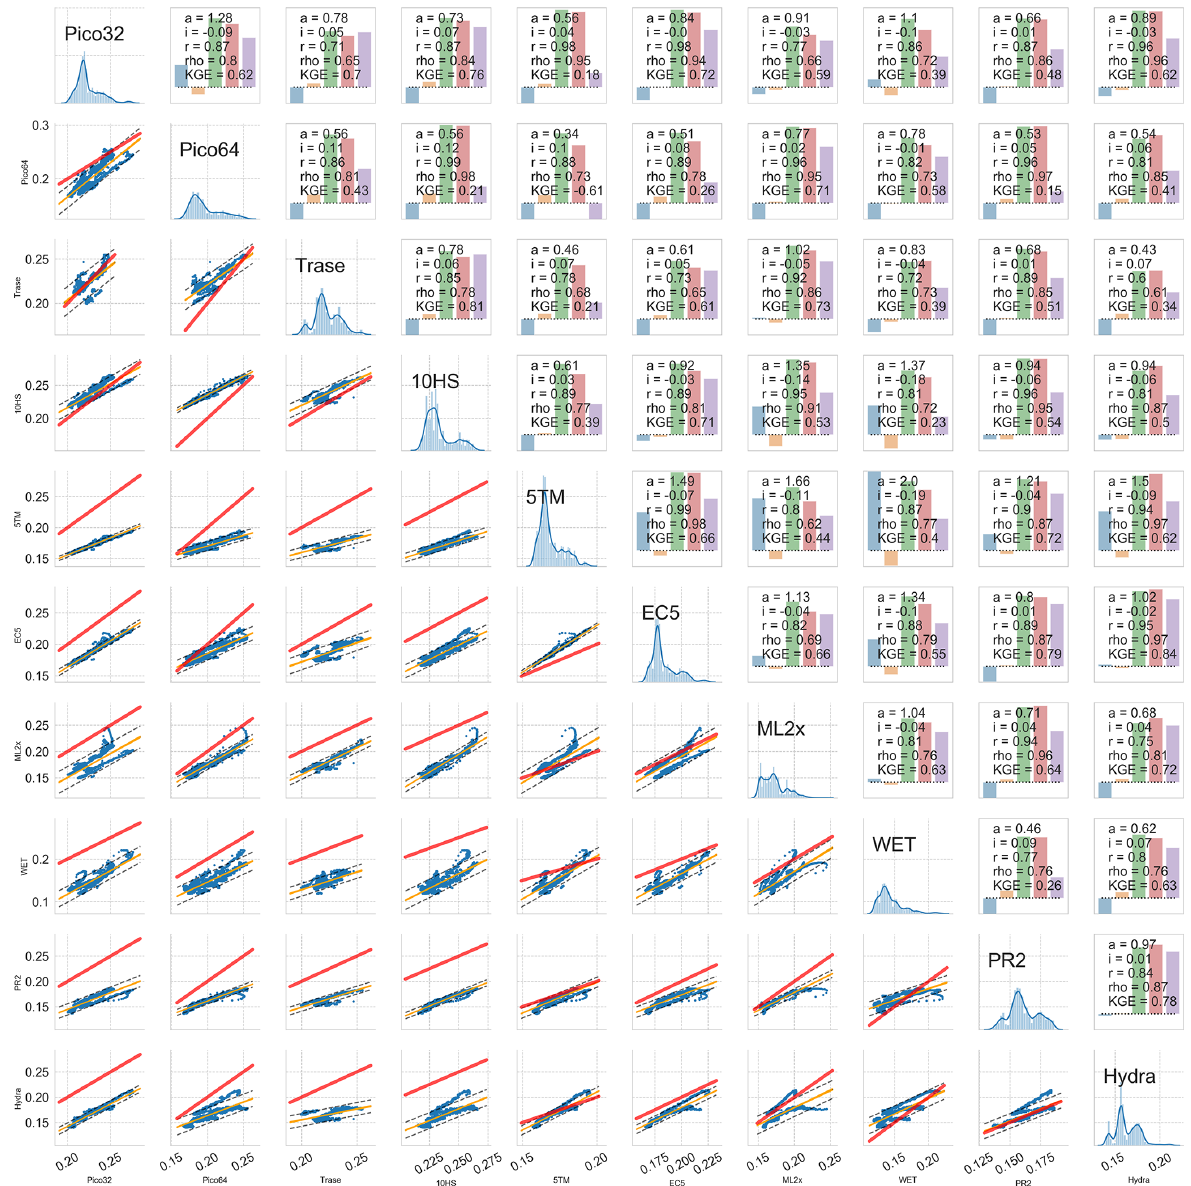
Figure 6. Correlation matrix of all plausible sensor systems measuring soil moisture (given in m 3 m − 3 ). Diagonal panels give histogram and kernel density distribution of 0.5h means of all sensors of one system. Lower half gives scatter plot (blue dots), linear regression (orange line), 0.95 predictive uncertainty bands (grey dashed lines) and the 1 : 1 line (red). The upper half reports the respective correlation measures, with a and i as scaling factor and intercept of the linear regression model, r as Pearson correlation coefficient, rho as Spearman rank correlation coefficient, and KGE as Kling–Gupta efficiency. These values are plotted as bars in the same order in the background, where a is plotted as deviation from